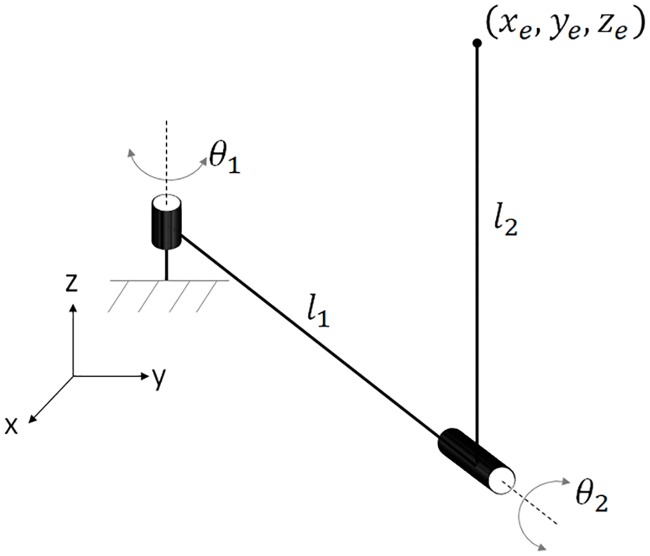
Two-link spatial robot for demonstration of the method.